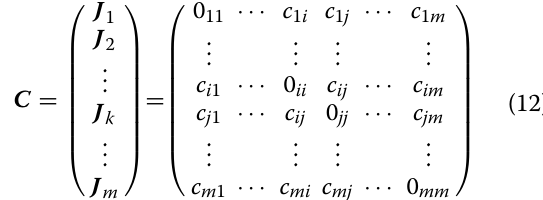
Table 1 Combination of n and p